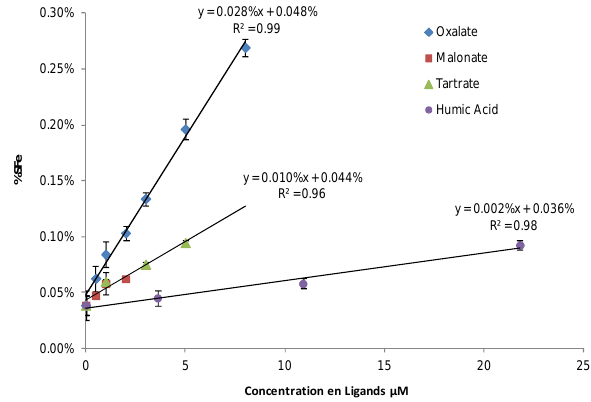
Fig. 1. Iron solubility (%) vs. organic species concentrations (µm Figure 1: Iron solubility (%) vs organic species concentrations (µM) for the 4 species M) for the 4 species affecting iron solubility at pH 4.7. Uncertainties affecting iron solubility at pH 4.7. Uncertainties represent one standard deviation of represent one standard deviation of triplicate triplicate experiments.